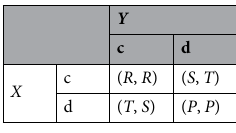
Table 1. Utility matrix in PD games.